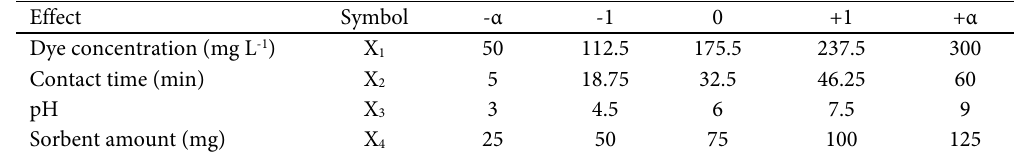
Table 1. Actual and coded values of independent variables applied for response surface method. Effect